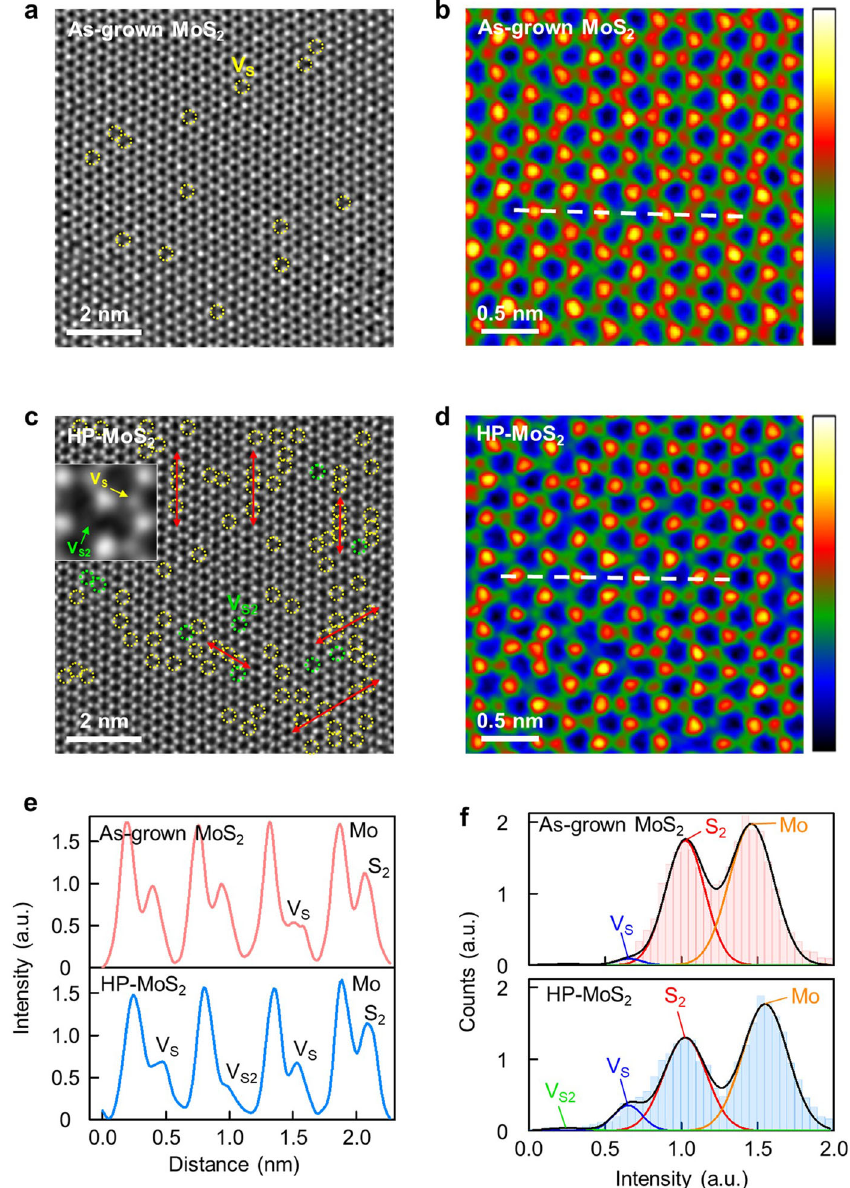
Fig. 2 Observation of atomic structure of MoS 2 and HP-MoS 2 using STEM. STEM images of a , b as-grown MoS 2 and c , d HP-MoS 2 . Yellow and green circles indicate the position of monosulfur (V S ) and disulfur vacancies (V S2 ), respectively. Red arrows indicate sulfur vacancies along zigzag orientation of MoS 2 . The inset shows enlarged STEM images and structure of V s and V S2 . e Intensity pro fi les obtained along the white dashed lines in b and d . f Distribution of intensities at S and Mo sites extracted from STEM images. The curve lines are Gaussian fi tting curves to